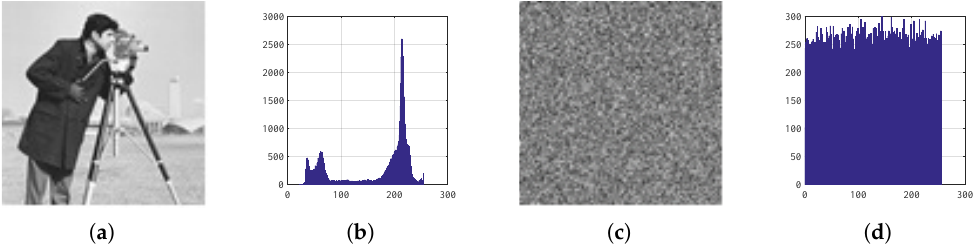
Figure 10. Histograms: ( a ) Cameraman image, ( b ) histogram of plain Cameraman, ( c ) encrypted Cameraman, and ( d ) histogram of encrypted